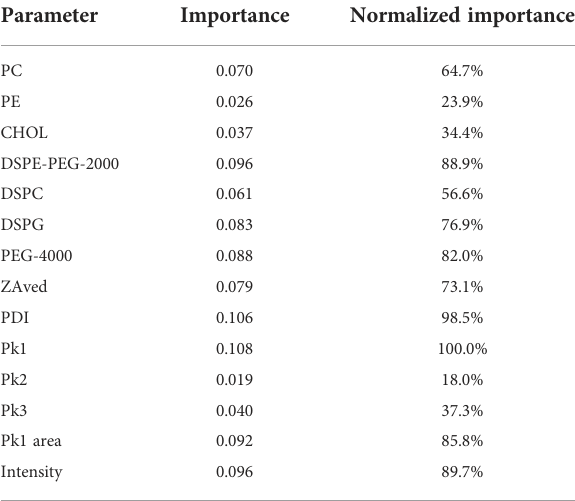
TABLE 3 Normalized importance contribution of each index.